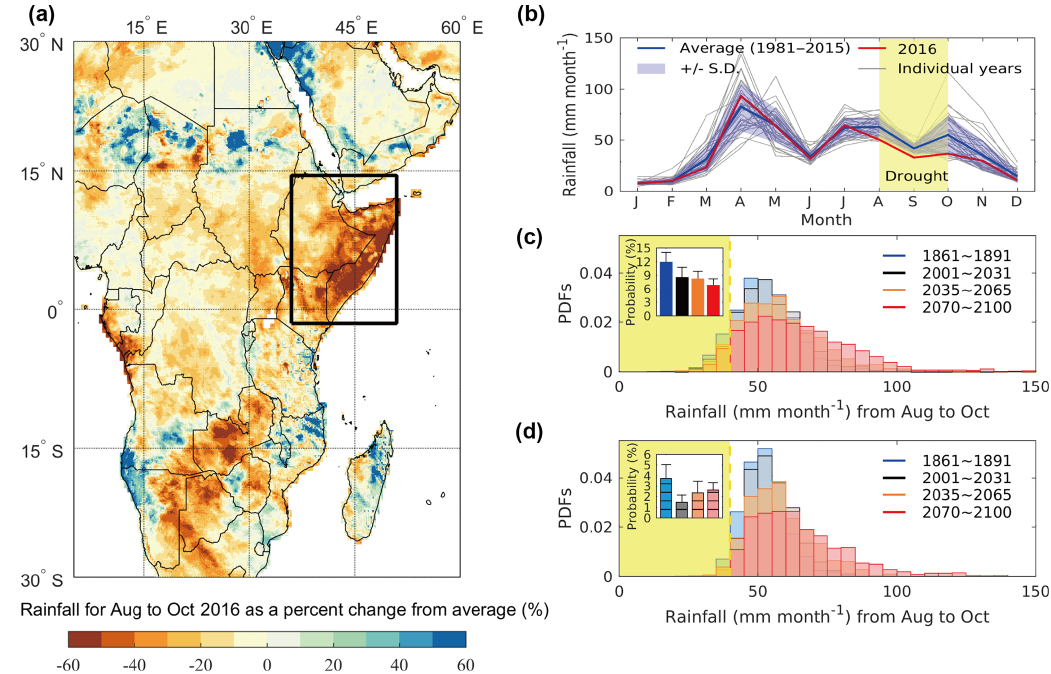
Figure 1. (a) Black rectangle is the location of the study region (14.5 ◦ N–1.5 ◦ S, 36–51 ◦ E). Plotted is mean rainfall for 2016 and months August to the end of October (ASO), presented as relative change (as %) to the long-term average ASO values (1981–2015). Values based on CHIRPS precipitation product. (b) CHIRPS-based monthly total rainfall (mmmonth − 1 ) over study region (panel a ; land within black rectangle) for years 1981 to 2016. Year 2016 is red, other years are individual grey lines, and multi-year average (not including 2016) is the blue line. Blue shading is ± 1SD of monthly rainfall across years 1981–2015. The drought event of 2016 is defined as the three consecutive months of ASO (yellow shading), and noting rainfall in that year is below blue shading in these months. (c) CMIP5-based probability density functions (PDFs; binned to 5mmmonth − 1 intervals) of mean ASO rainfall for periods 1861–1891 (blue), 2001–2031 (black), 2035–2065 (orange) and 2070–2100 (red). Each curve corresponds to combined estimates from 37 CMIP5 GCMs, with each GCM forced by historical emissions and RCP8.5 future scenario. Individual GCM mean bias correction is based on the CHIRPS precipitation product. Yellow shading is mean ASO rainfall less than 40mmmonth − 1 , which is the CHIRPS 2016-based threshold (mean of ASO, red curve in panel b ). Inset shows probabilities of mean rainfall of ASO falling below the threshold for the same modelled periods (colours match those of curves and legend). The error bars are 2SD (estimated via bootstrapping 80% replications from the 37 GCM precipitation data for the 31-year periods). (d) Same as (c) , but based on the mean- and variance-corrected GCM rainfall